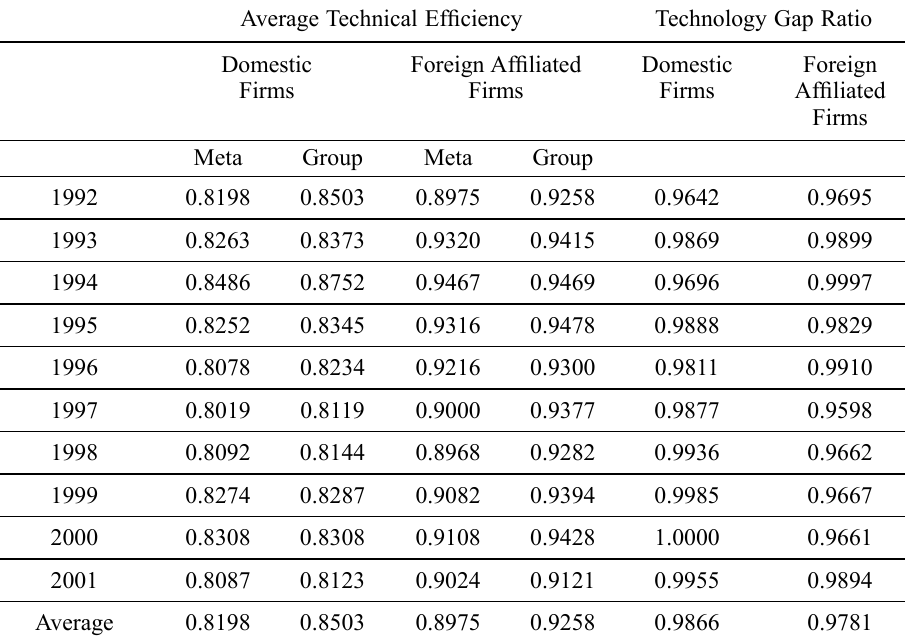
Table 2. Average Technical Efficiency and Technology Gap